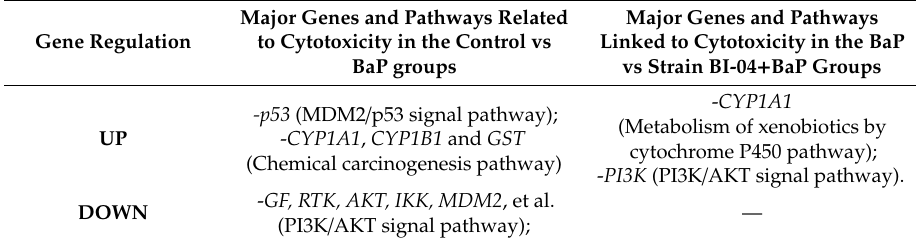
Table 3. Main genes and pathways of treated colon epithelial